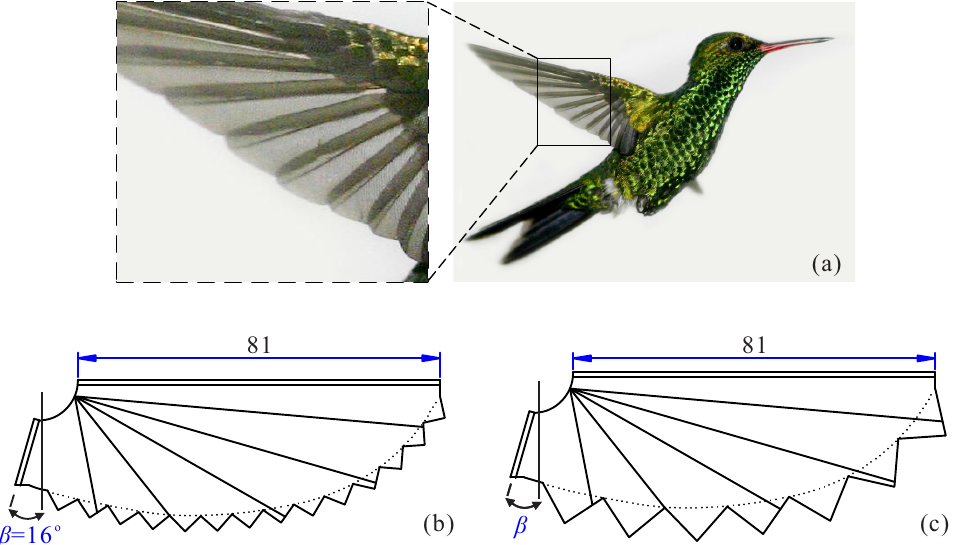
Figure 7. Wings with trailing edge serration. ( a ) Hummingbird Chlorostilbon canivetii (source: Wikipedia). ( b ) Small serration. ( c ) Large serration. The nominal wing is in dotted